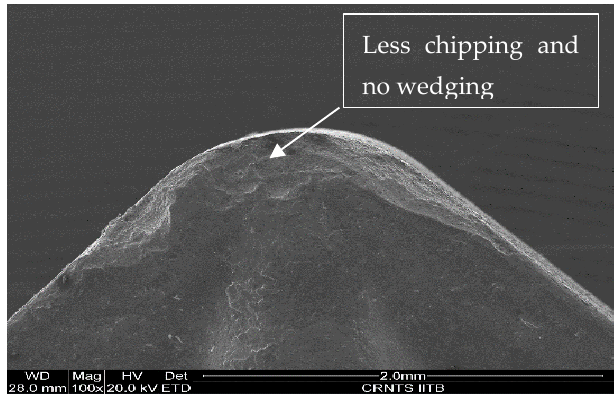
Figure 3. Crater wear with optimized parameters.